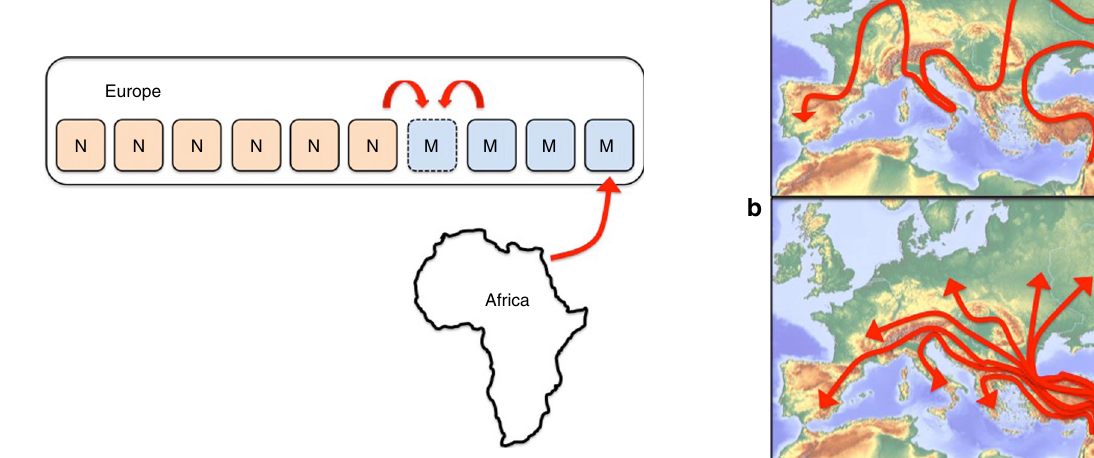
Fig. 7 An illustration of the 1-D stepping-stone model. Each deme is